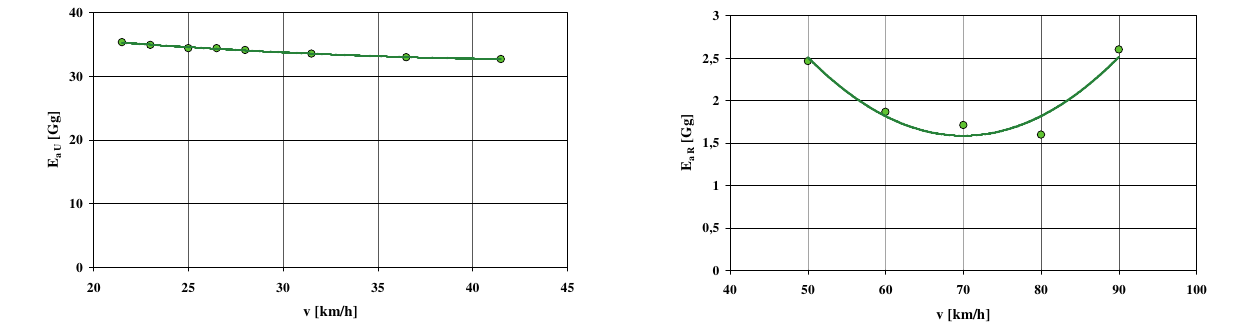
Fig. 11. Dependence of the national annual emission of particulate matter Fig. 7. Dependence of the national annual emission of nitrogen oxides PM10 from tribological elements of passenger cars upon the average from passenger cars upon the average velocity, under model conditions of velocity, under model conditions of rural traffic urban traffic